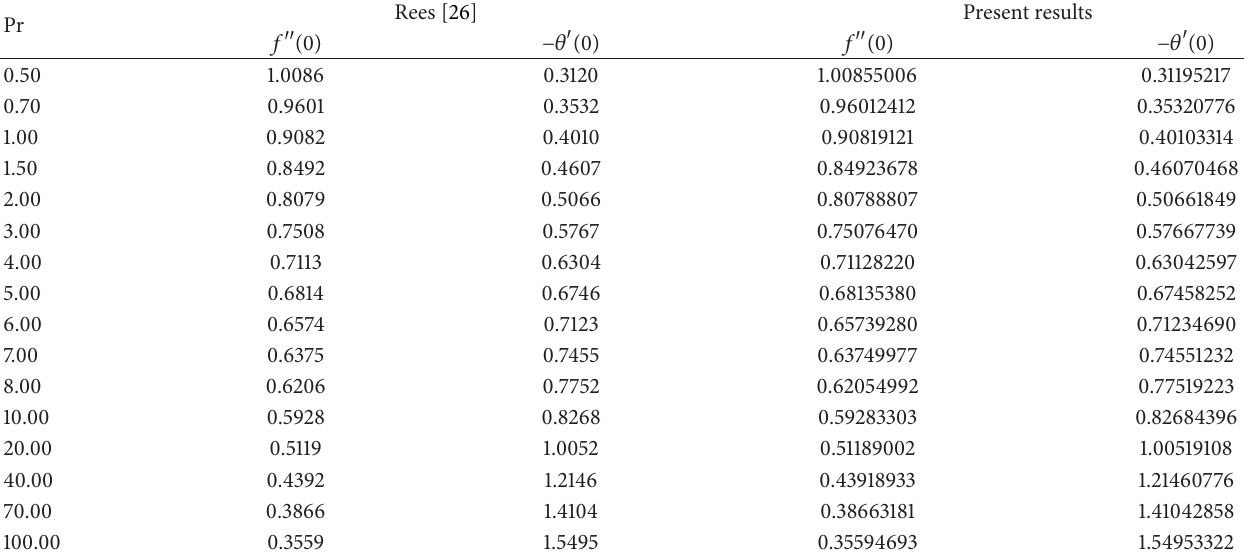
Table 1: Comparisons of wall skin-friction coefficient 𝑓 󸀠󸀠 (0) and local Nusselt number −𝜃 󸀠 (0) with those of Rees [26] for various values